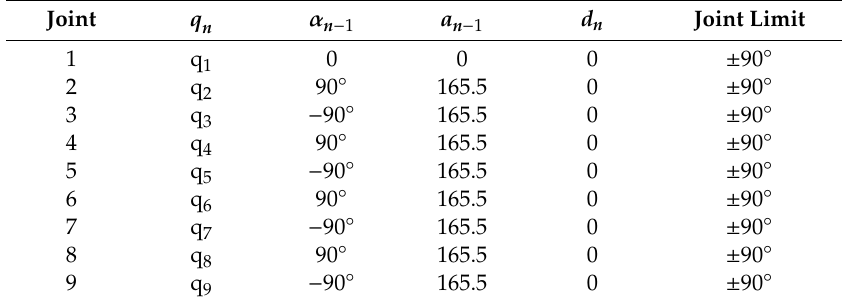
Figure 4. Manipulator structure and link coordinate systems of the 9 DOF manipulator. Table 1. Denavit–Hartenberg parameters of the nine degree-of-freedom (9 DOF) manipulator. Joint q